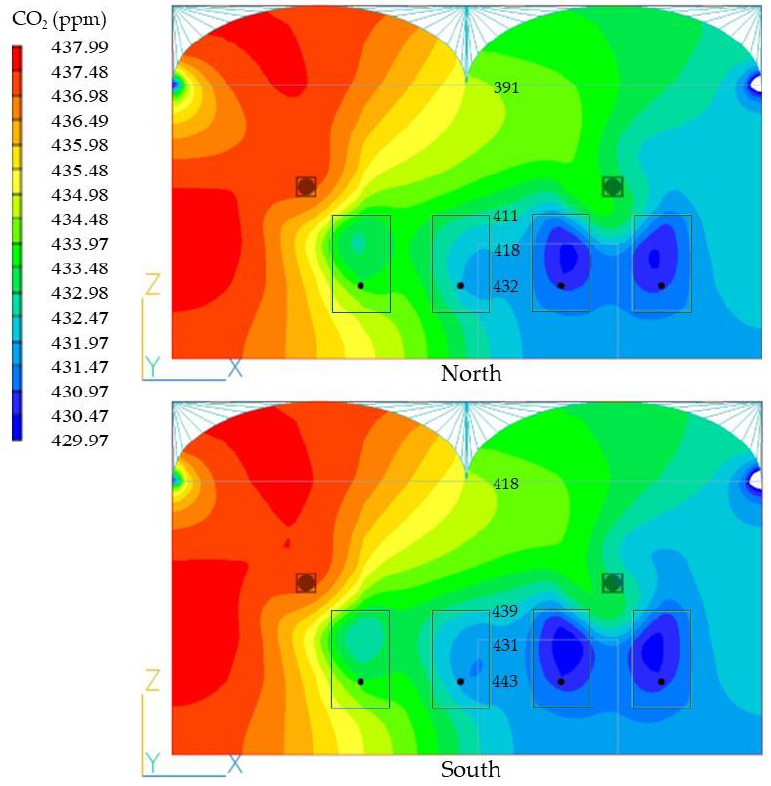
Figure 11. CO 2 distribution inside the greenhouse considering CO 2 absorption through photosyn- thesis by plants (image taken at cross-section 3.4 m from south